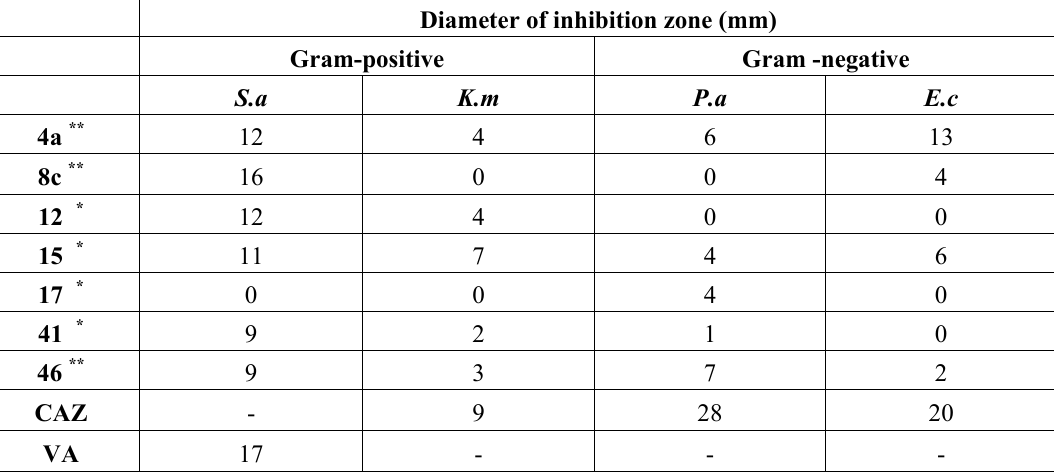
Table 2. Antimicrobial activity of the select synthesized